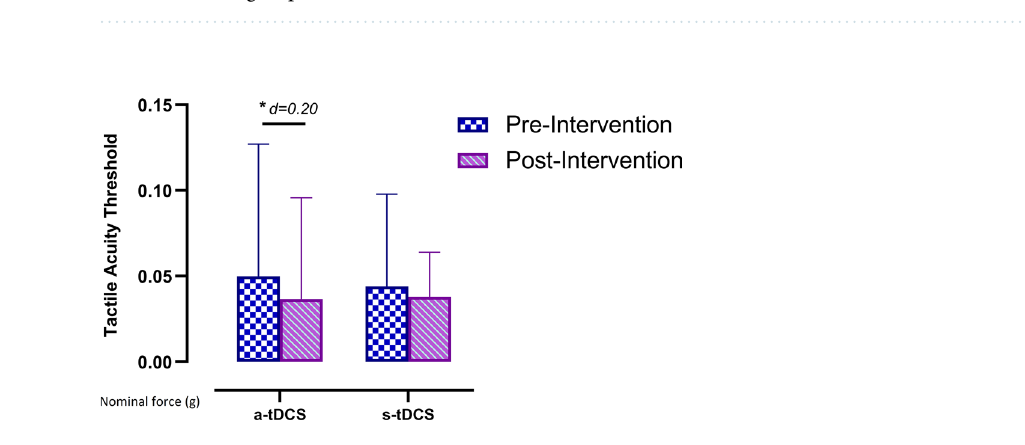
Table 1. Participants’ general characteristics. Values are shown as the mean ± SD. a-tDCS: experimental group; s-tDCS: control group.